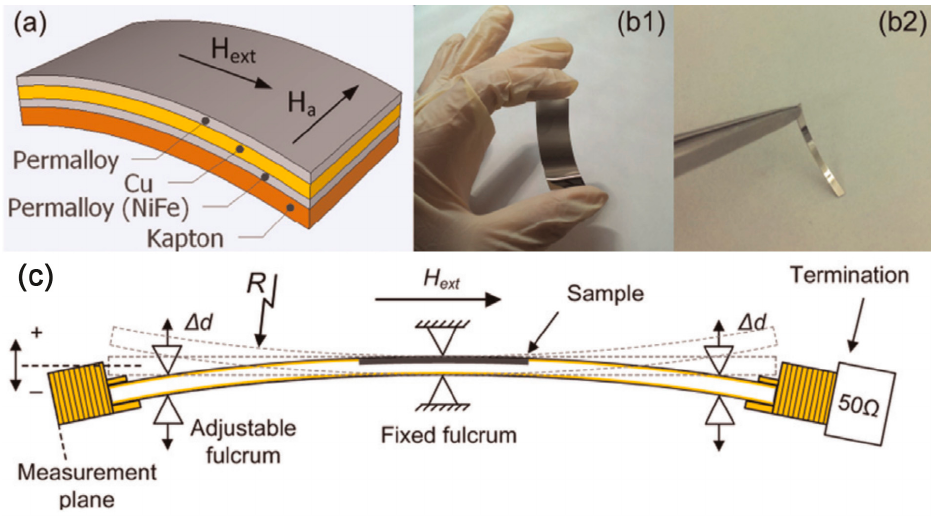
Figure 13. ( a ) The device architecture of the flexible GMI sensor based on a Kapton substrate; ( b1,b2 ) Physical picture of the flexible GMI sensor; ( c ) Schematic diagram of deflection measuring device for flexible GMI sensor. Adapted with permission from Ref. [97]. Copyright 2014, copyright Elsevier B.V.